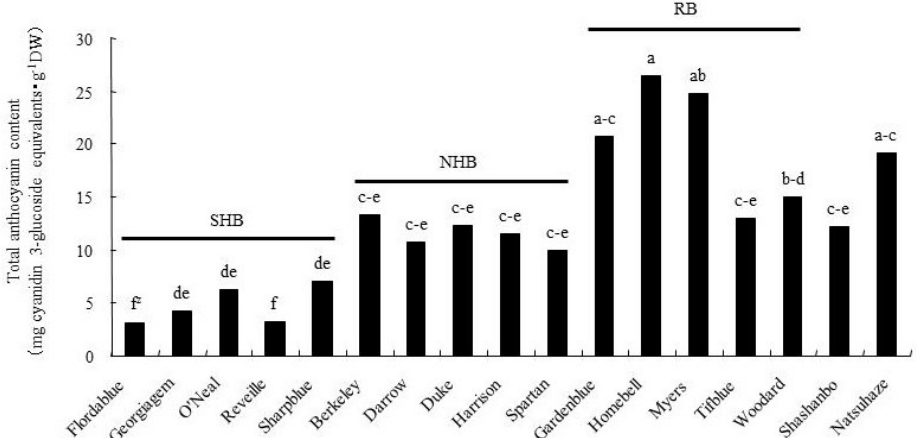
SHB: Southern highbush blueberry. NHB: Northern highbush blueberry. RB: Rabbiteye blueberry. Shashanbo ( Vaccinium bracteatum Thunb.) and Natsuhaze ( V. oldhamii Miq.). z Different letters represent significant differences in Tukey’s multiple range test, 1% level.